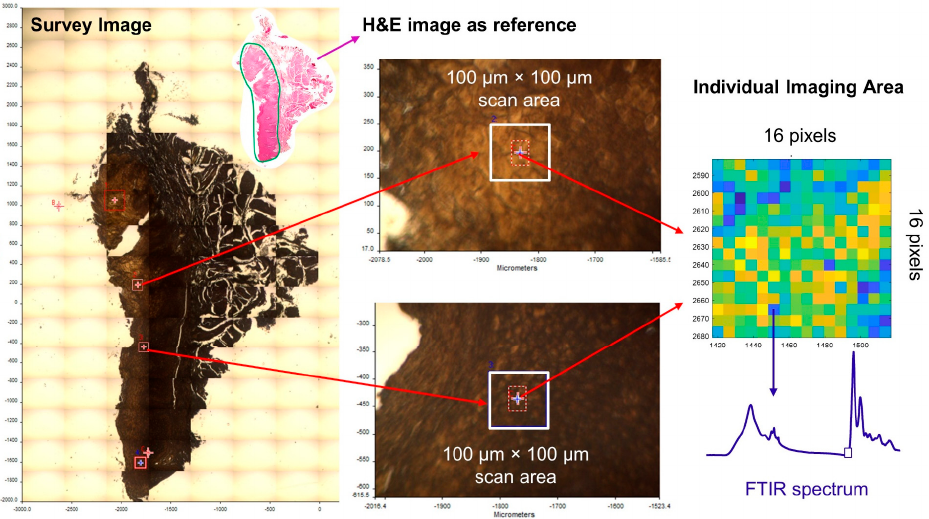
Figure 2. Illustration of FTIR imaging areas for a sample section.